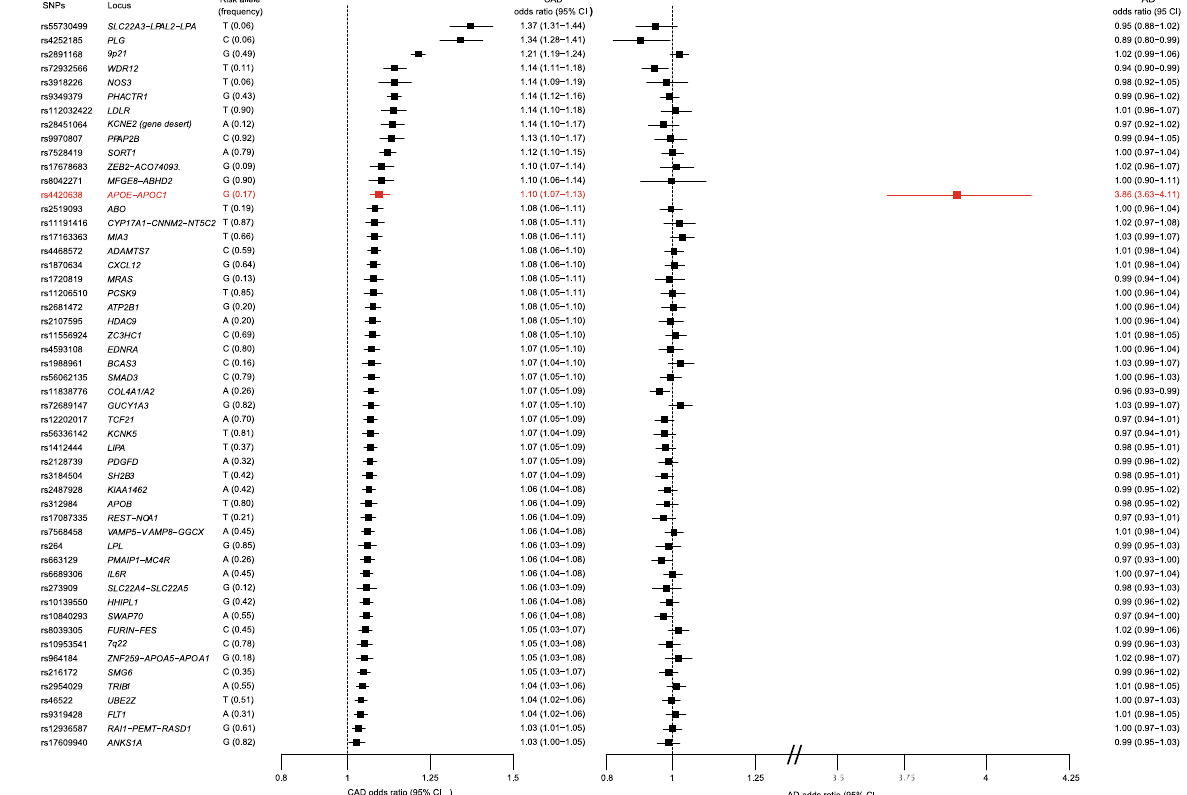
Figure 1. Forest plot of variants included in the Mendelian randomization analysis of the causal relevance of CAD for LOAD. Forest plot of odds ratios (OR) for the 52 variants used in the analysis with CAD and LOAD. Variants are reported for the increasing CAD risk allele (i.e. CAD ORs are > 1). The APOE locus is marked in